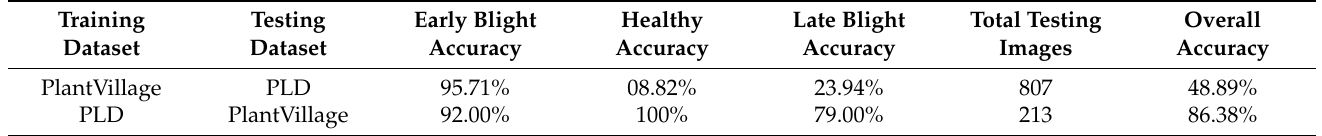
Table 9. Classification accuracies of the proposed PDDCNN model training on PlantVillage and testing on PLD and training on PLD and testing on the PlantVillage